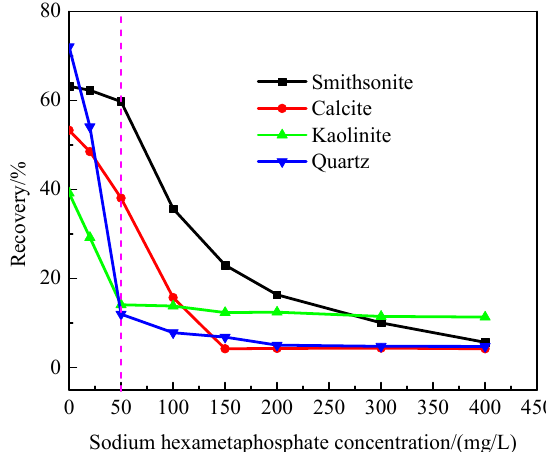
Figure 11. Effect of sodium hexametaphosphate on flotation recoveries of smithsonite and gangue minerals using octadecylamine concentration: 150 mg/L at pH 9.5–10 and 28.57% solid concentration.